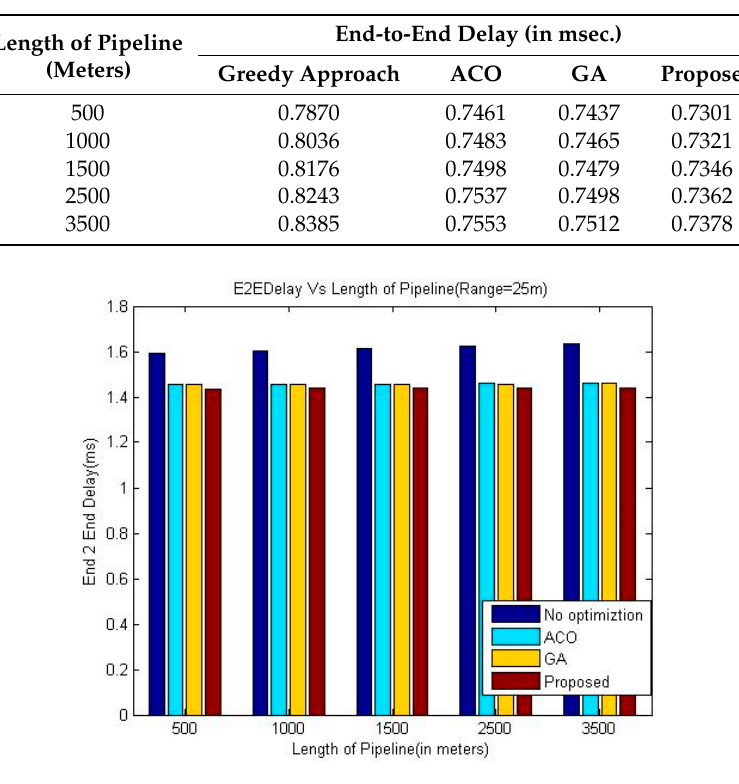
Figure 3. Comparison of End-to-End delay (Range 25 m).